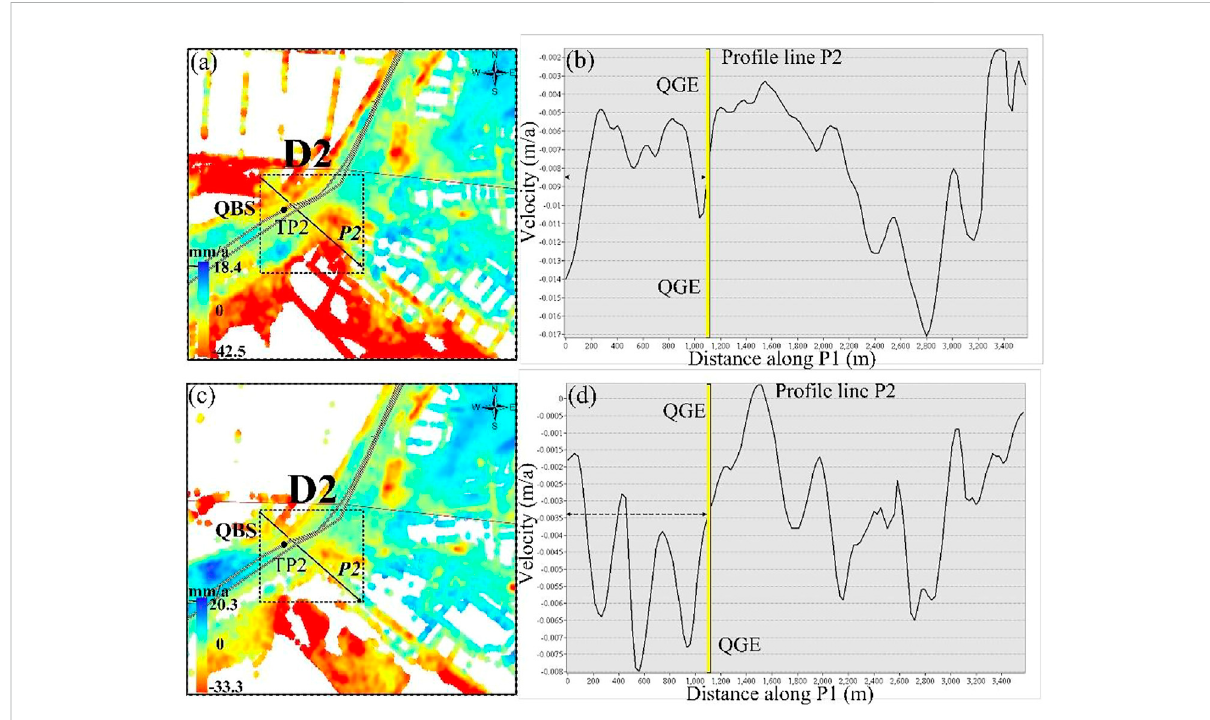
FIGURE 12 LargeversionLOSannualaveragedeformationvelocitymapfrom2018to2022ofareaD2andpro fi leline P2 . (A) and (B) indicatetheascending results, (C) and (D) indicate the descending results. The yellow trace represents the location of QGE along the pro fi le line.